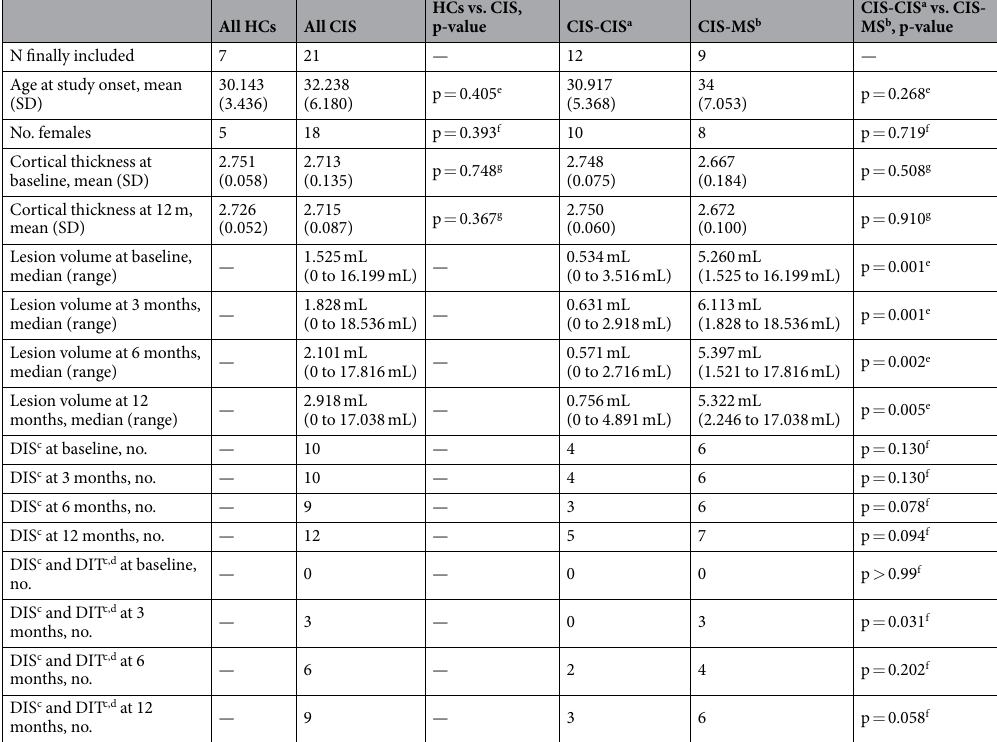
Table 1. Demographical, clinical and MRI characteristics of the study cohort. a Patients who did not have a second attack during the follow-up; b patients who had a second attack during the follow-up; c according to the 2010 Revisions of the McDonald Criteria; d patients did not undergo a whole-brain T1-weighted scan after Gadolinium injection. Therefore, it was not possible to assess whether gadolinium-enhancing lesions were coexisting with non-gadolinium-enhancing lesions, at any time point; e two-sample t-test; f chi-square test; g linear regression adjusting for age, gender and T2 lesion load. Abbreviations: CIS: clinically isolated syndrome; DIS: dissemination in space; DIT: dissemination in time; HCs: healthy controls; SD: standard